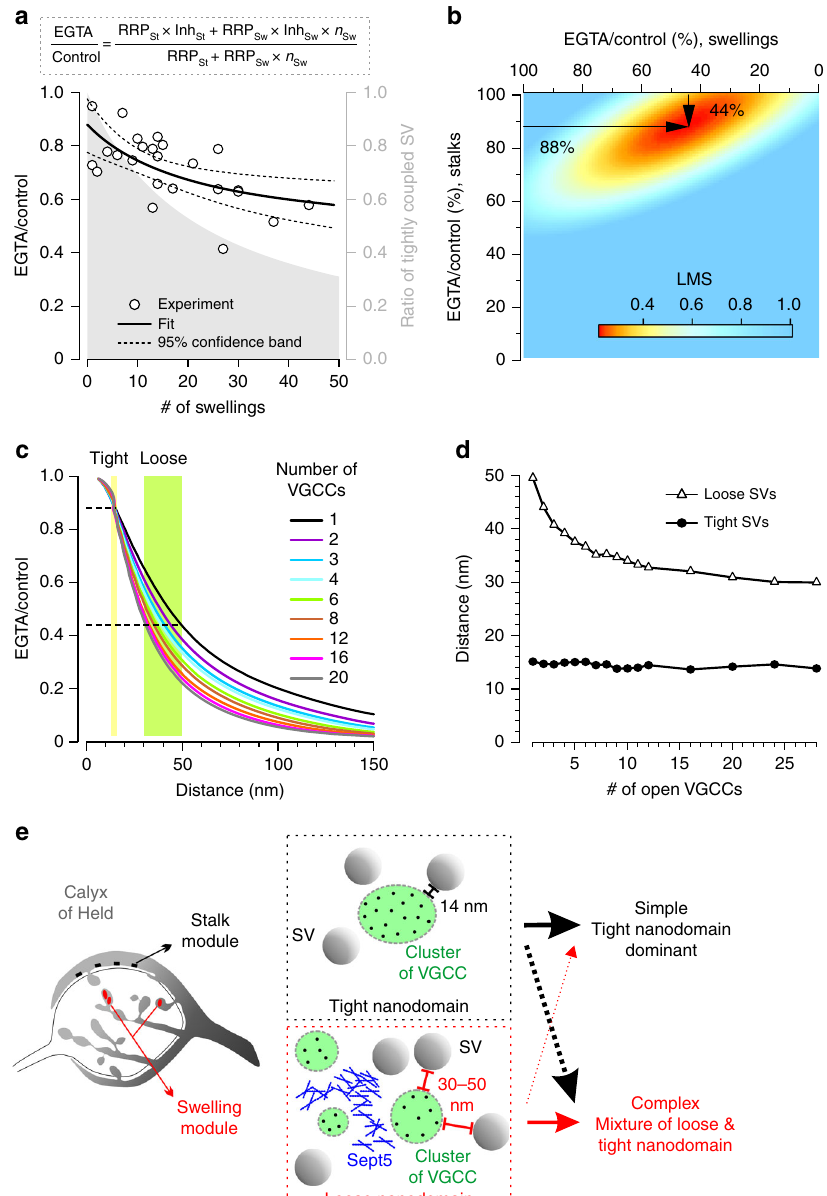
Fig. 9 Numerical simulation of the VGCC-SV coupling distance reveals subpools of synaptic vesicles. a EGTA effect on EPSC amplitudes (EGTA/control) was plotted against the number of swellings (circles) and fi tted (black) with the equation ± 95% con fi dence interval (dashed; see Equation (3) in Results). n Sw is the number of swellings, RRP St and RRP Sw are the RRP (readily releasable pool) sizes in entire stalks and per swelling, Inh St and Inh Sw are the inhibitory effects of EGTA in stalks and swellings, respectively. The gray zone (right axis) exhibits the occupancy of tightly coupled vesicles. b The least mean squares (LMS) of the fi t exhibit the best EGTA effect in swellings ( X -ordinate) and stalks ( Y -ordinate). c The magnitude of inhibition by EGTA is a function of distance between vesicular Ca 2 + sensor and voltage-gated Ca 2 + channel (VGCC) cluster perimeter. Horizontal dashed lines indicate the EGTA inhibition in stalks (0.88) and in swellings (0.44). Vertical shaded regions indicate the range of distances between the sensor location and nearest open VGCC matching EGTA inhibition for different number of VGCCs in cluster. d Estimated coupling distance of loose and tight SVs were plotted against the number of VGCCs in cluster. e We describe a modular model of the heterogeneity in synaptic function. Variable proportions of distinct morphological modules (i.e. swelling and stalk) de fi ne functional heterogeneity. The stalk module (black) contains synaptic vesicles (SVs) with tighter coupling (14 nm; tight nanodomain) to larger VGCC clusters present in lower density. The swelling module (red) contains SVs with looser coupling (30 – 50 nm; loose nanodomain) to smaller clusters present in higher density. Septin 5 (Sept5) differentiates the coupling distances. Simple calyces mostly contain stalk modules while complex calyces are composed of a mixture of stalk and swelling modules. Arrows represent the contribution of the